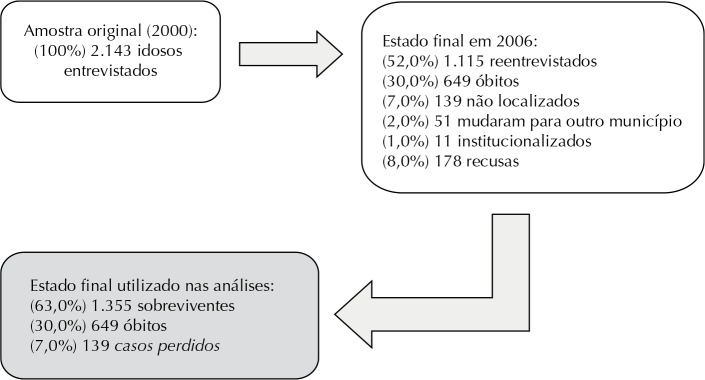
Estado final considerado na amostra analisada. São Paulo, SP, 2000 a 2006.